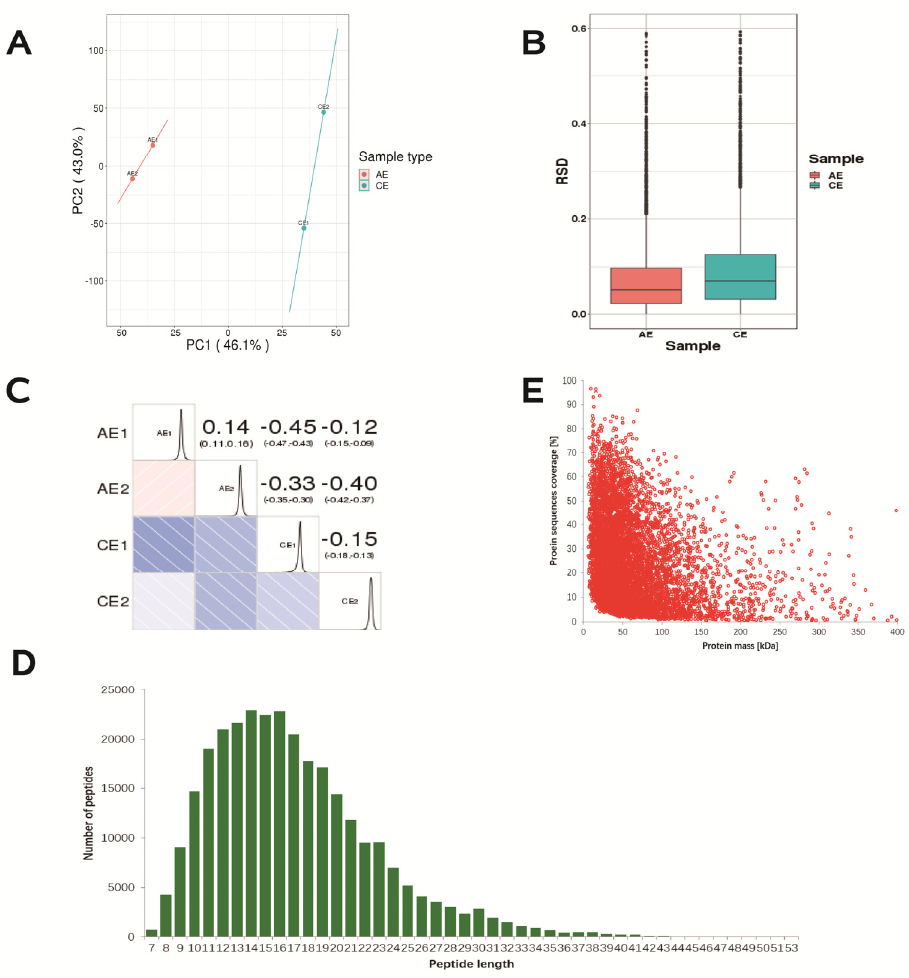
Figure 6. Repeated sample consistency test and identification of differential proteins. ( A ) Two − di- mensional sca tt er plot of protein quantitative principal component analysis (PCA) between replicate samples. ( B ) Boxplot of protein quanti fi cation of the relative standard deviation (RSD) distribution between replicates. ( C ) Pearson correlation coe ffi cient (Pearson) heatmap for protein quanti fi cation between pairwise samples. ( D ) Length distribution of peptides identi fi ed by mass spectrometry. ( E ) Relationship between molecular weight and coverage of proteins identi fi ed by mass spectrometry.